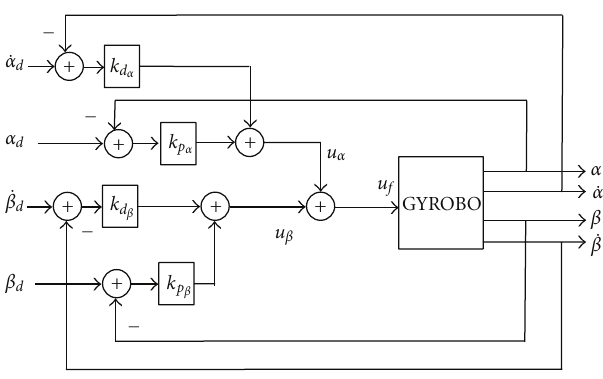
Figure 4: Straight line tracking control structure.